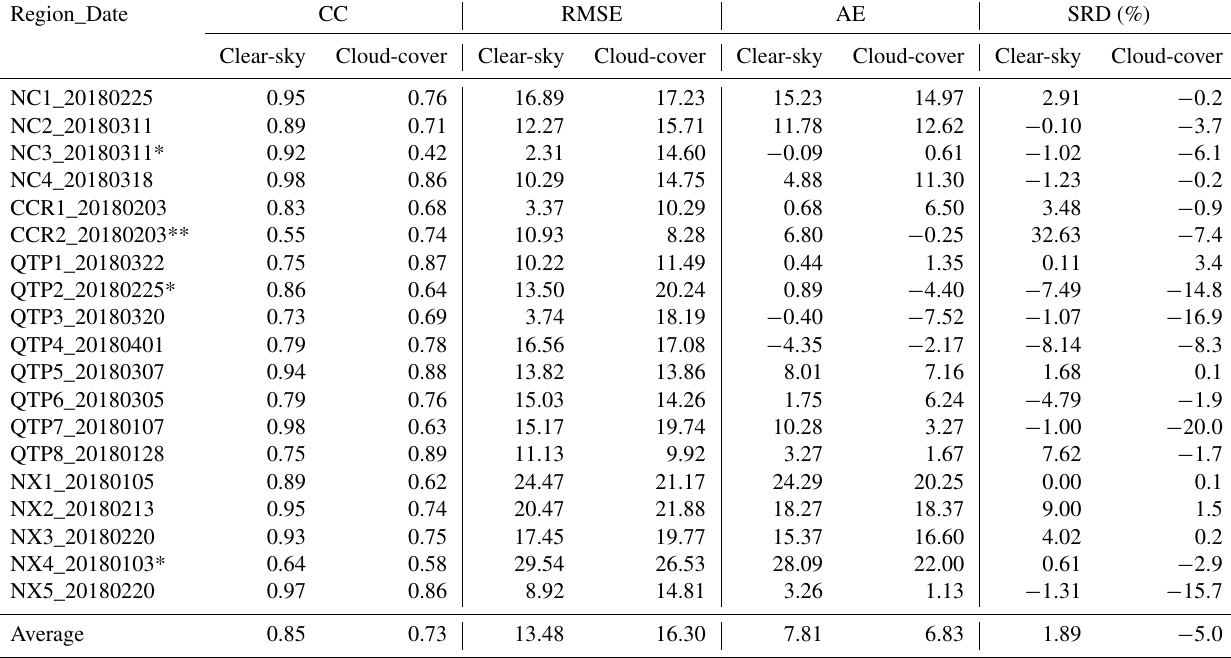
Table 8. Performance statistics for STAR NDSI collection against Landsat NDSI maps in clear-sky and cloud-covered areas according to the TAC dataset. Note that ** and * respectively indicate an improvement and degradation of cloud-covered areas compared to clear-sky areas (corresponding to four groups in Fig.